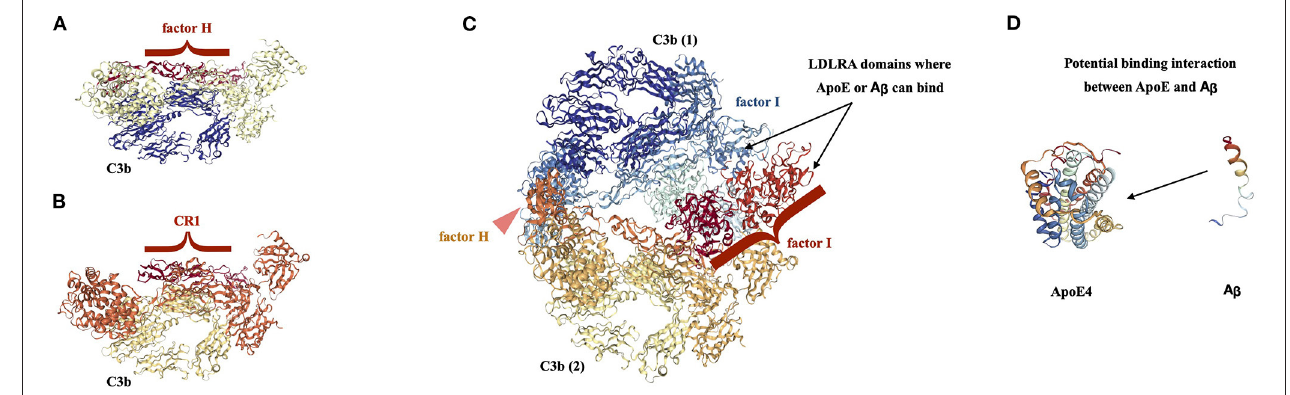
FIGURE 7 | Proposed complex of CR1 + 7S with Additional Plasma Factors Associated with AD. Crystallographic structures from Protein Data Bank for selected RCA proteins in complex with Complement C3b. Original source for the crystallographic structures, Piet Gros laboratory (Wu et al., 2009; Forneris et al., 2016; Xue et al., 2016). These structures are used as a basis to suggest a macromolecular complex of the composition: CR1 + 7S: C3b: C3b: CR1 + 7S: ApoE. (A) Factor H: C3b complex; PDB structure, 2W11. This is a structure of the tub-like C3b structure in cream and navy, and the extended paddle-like structure of the four Sushi domains of factor H that bind to C3b resting on the lip of the tub, in brick red. (B) Complement Receptor 1: C3b complex, PDB structure 5FO9. This is a structure of the tub-like C3b structure in gold, and burnt orange, with the extended paddle—like structure of the four Sushi domains of Complement Receptor 1 that bind to C3b resting on the lip of the tub, in brick red. A comparison of the two C3b complexes where the binding partner is an RCA protein domain of consecutive Sushi domains yields many similarities. If one uses the base of the structure where there is a circular alpha helical tunnel as an orientation point, it can be seen that the C3b portion of the structures are similar to one another in pattern with similar layers of protein secondary structure. The upper surface of C3b is similar in each case and the Sushi domains of the RCA protein nestle within the middle of the structure in a nearly linear array of Sushi domains. (C) Factor H: C3b: Factor I complex; 5O32. This is a structure of two C3b domains, one in the lower half of the structure that is oriented analogously to the C3b subunits in 5a and 5b, colors yellow and gold, and a second C3b subunit in the upper half of the structure that is inverted, colors navy, slate blue. Within the middle of the C3b “sandwich” are both a Factor H Sushi string in burnt orange, and a Factor I subunit, in aqua and two shades of red. An analogous ternary structure for CR1, C3b, and factor I does not exist, but we believe that such a structure would be similar to this one, based on the extensive similarity of the Factor H: C3b and CR1: C3b structures that can be observed in (A,B) . We contend that this structure is informative about the arrangement of a mega complex that might include A β or APP binding to the Sushi domains of CR1, quite possibly at the newly formed Sushi – Sushi interfaces made due to the seven Sushi duplication and insertion, and Apo ε binding to the LDLR-A domains of factor I, shown in the two shades of red in (C) . (D) ApoE and A β are two additional binding partners that may bind to the complex via the LDLR domains in factor I. Each of these factors may bind to an LDLR domain, or the complex of ApoE |A β may bind to an LDLR domain.